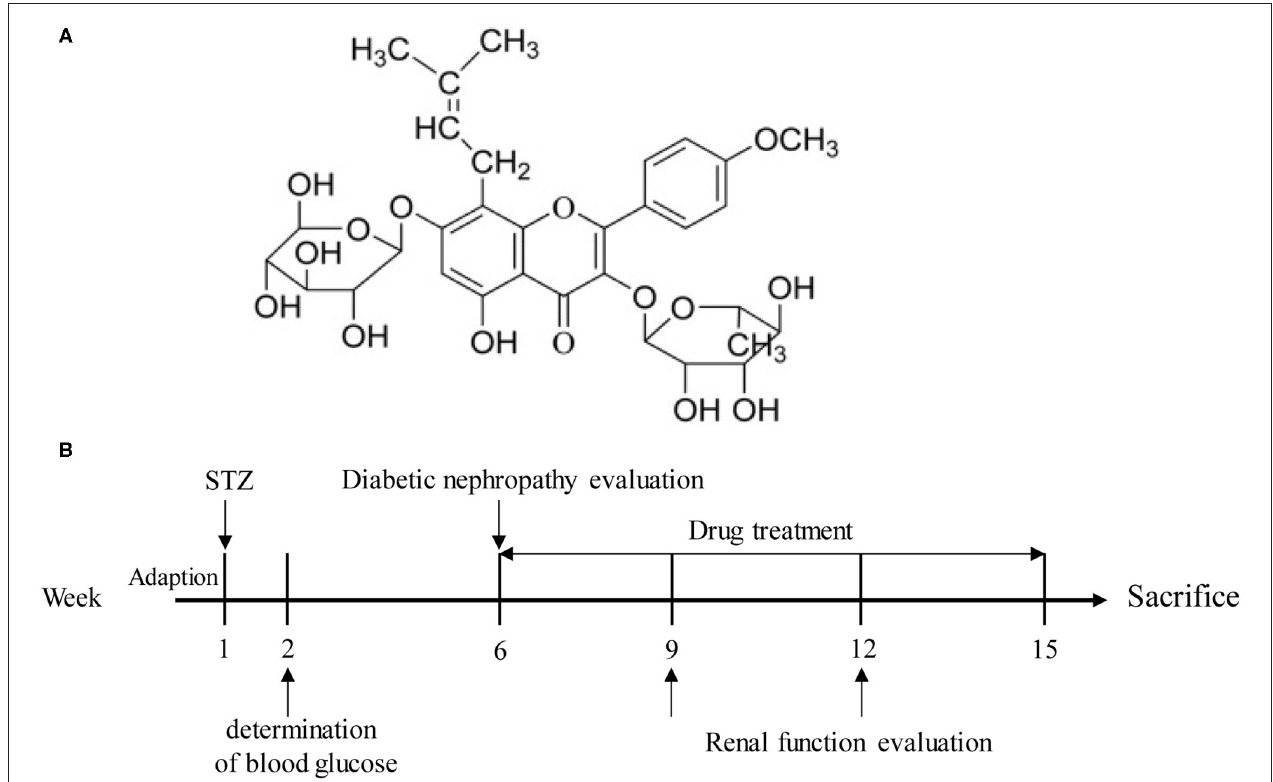
FIGURE 1 | (A) Structure of icariin. (B) A schematic representation of the diabetic nephropathy procedure and treatments in